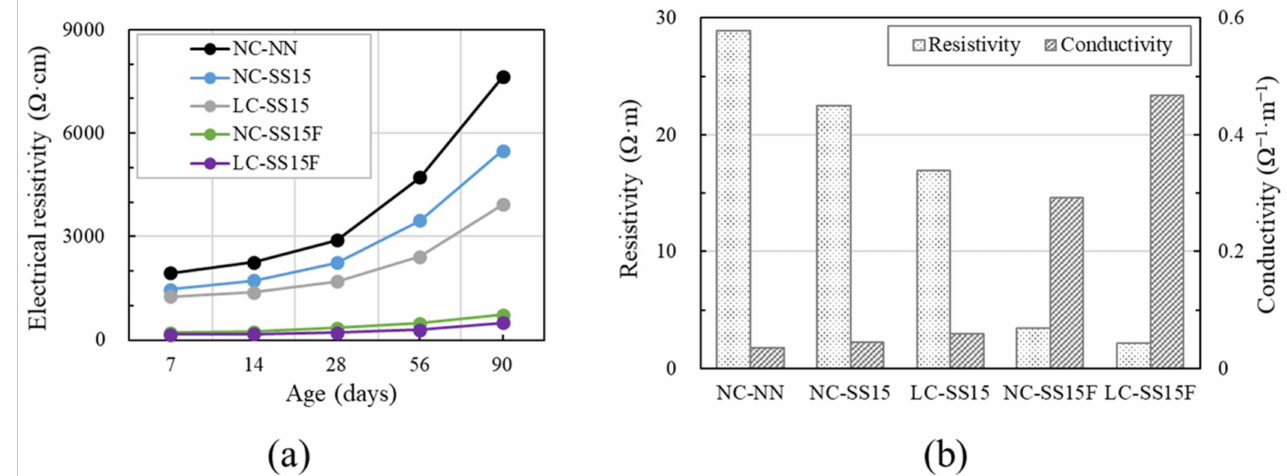
Figure 8. Comparison of electrical properties of concrete: ( a ) electrical resistivity at different ages; ( b ) electrical resistivity and electrical conductivity at 28